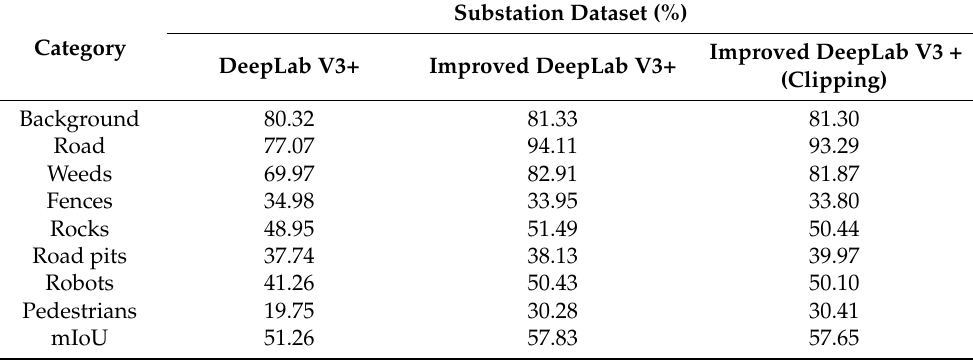
Table 5. IoU test results of each